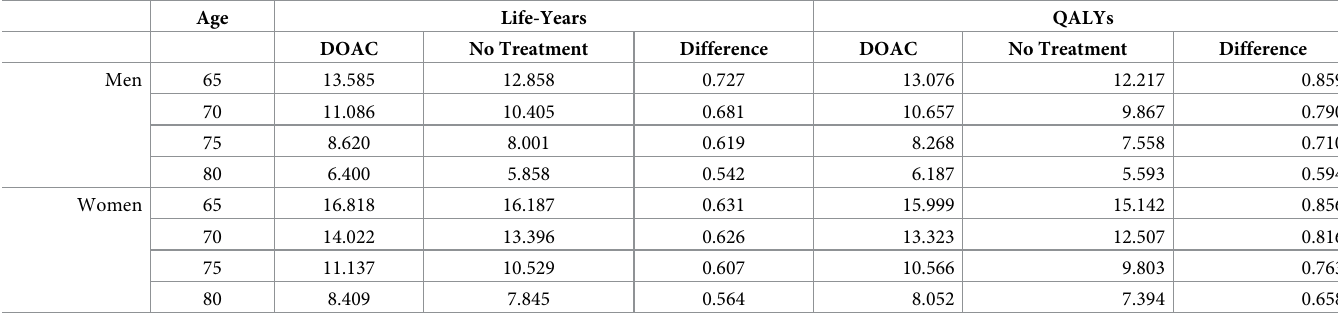
Table 5. Estimated difference in life-years and QALYs by sex and